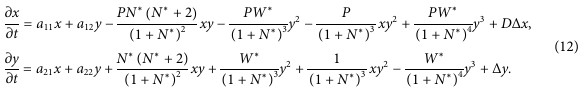
Frontiers in Physics |